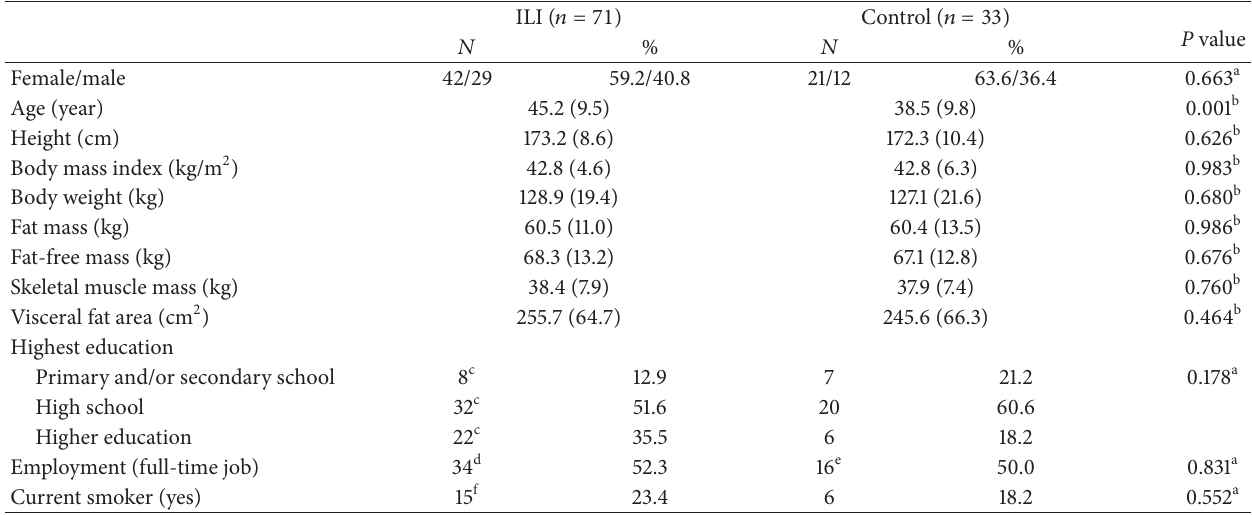
Table 1: Characteristics of participants and body composition at baseline in the intensive lifestyle intervention (ILI) group and control group. Data are given as mean values (standard deviation) or number of subjects and